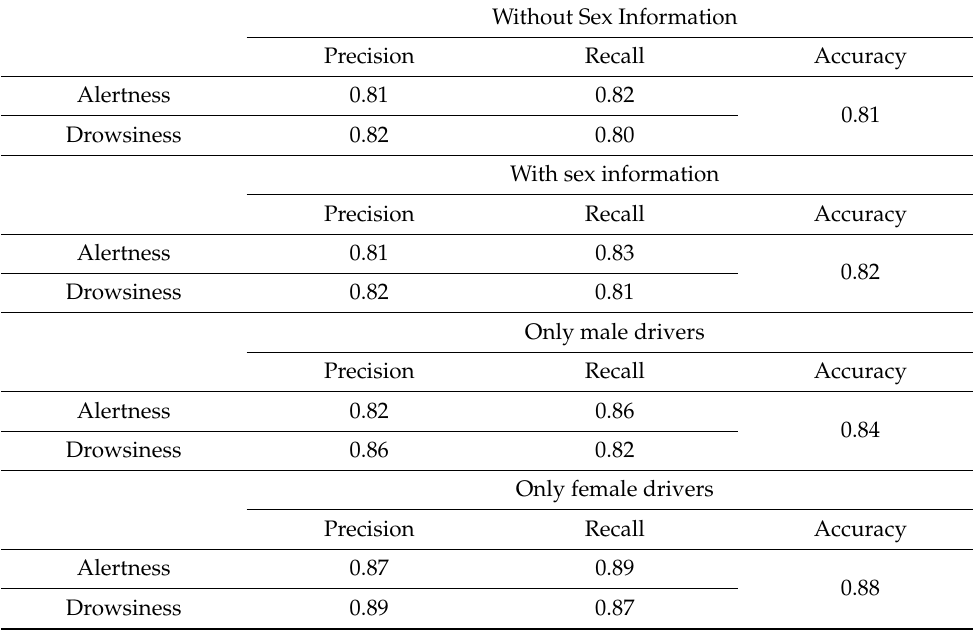
Table 4. Results of the drowsiness classification model.